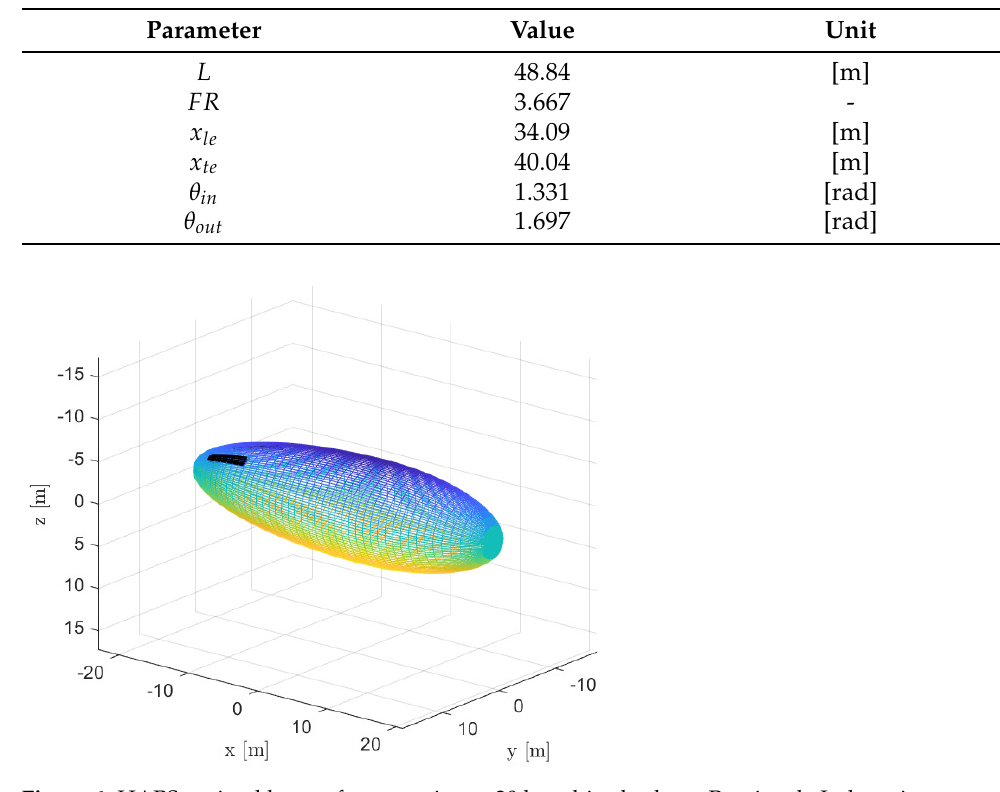
Table 7. Design variables defining the HAPS optimal layout for operation at 20 km altitude above Pontianak, Indonesia.